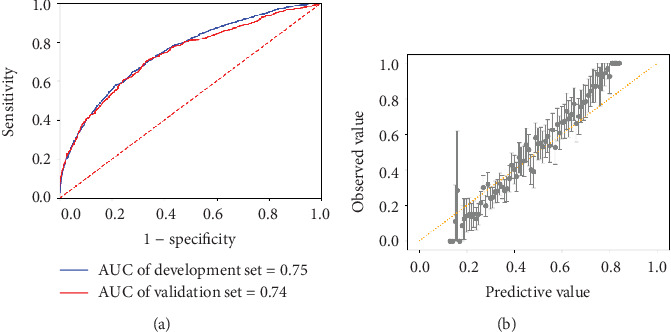
Predictive performance of the GBDT model. (a) AUCs of the development and validation cohorts. (b) The graph presents the calibration curve of the GBDT model by showing the relationships between observed and predicted GDM using the GBDT model. Data are presented as mean and 95% CIs.